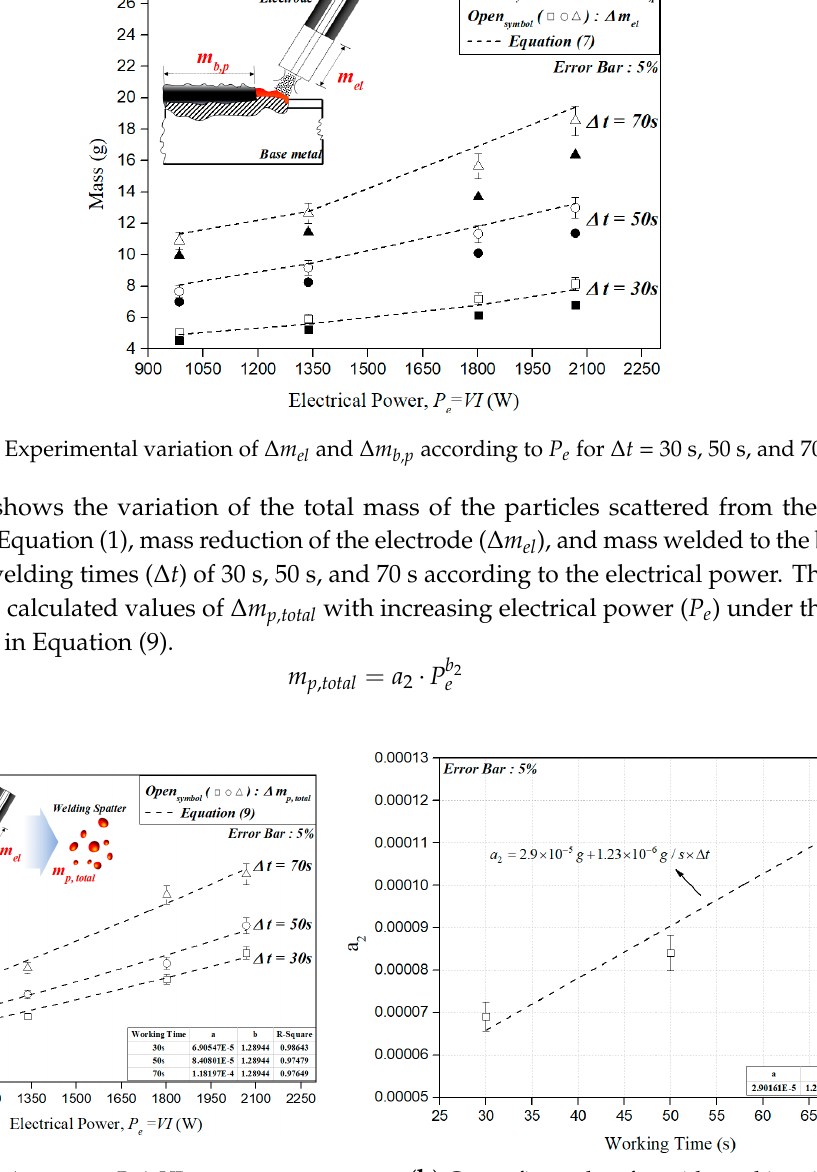
Figure 5. Effects of electrical power on the total mass of welding particles at welding times of 30 s, 50 s, and 70 s.